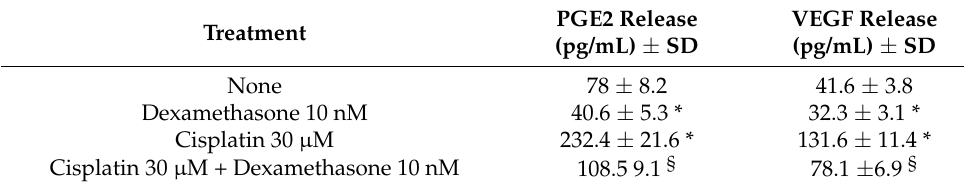
Table 1. Prostaglandin production and VEGFA release in BCPs stimulated and not stimulated by cisplatin 30 µ M in the absence or in the presence of 10 nM dexamethasone for 48 h.